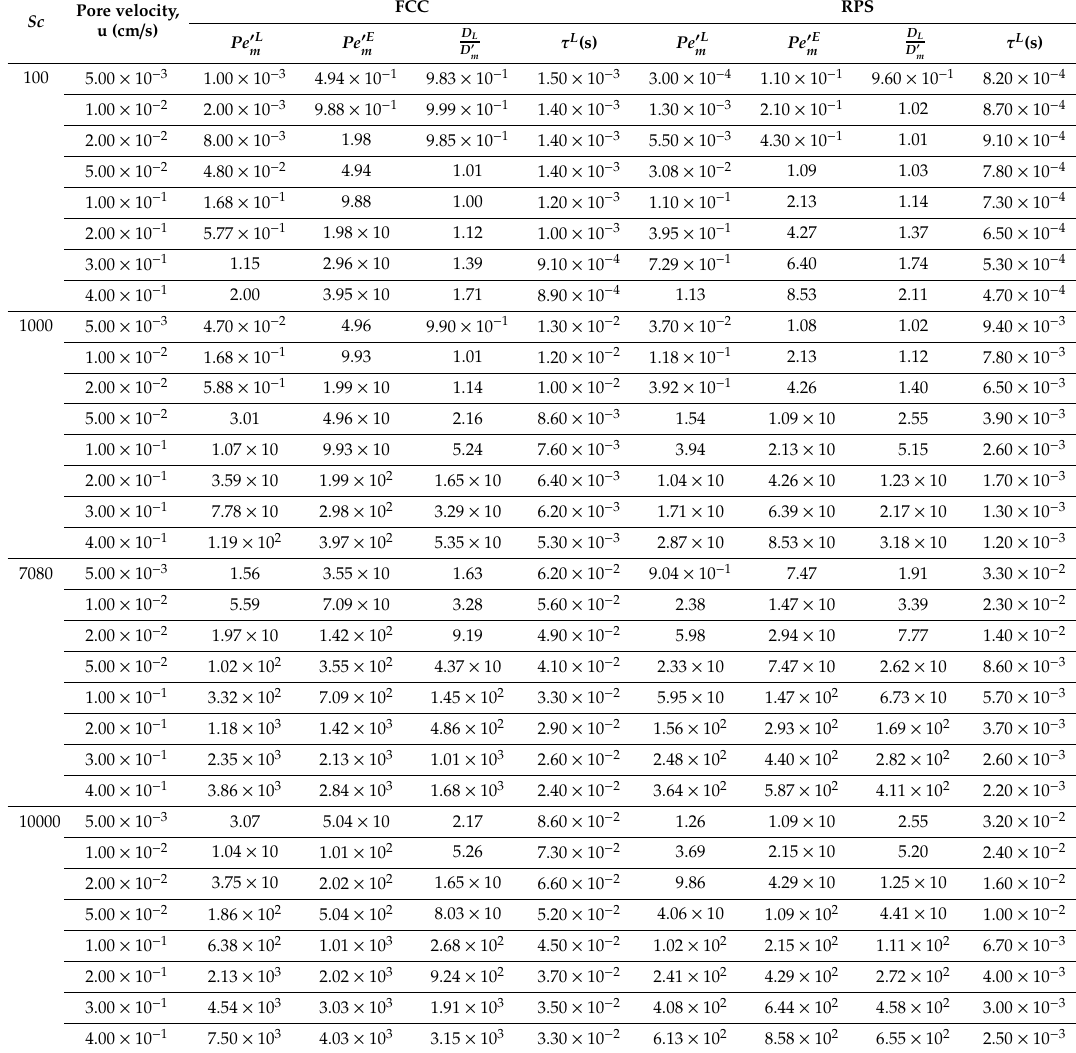
Table A2. Summary of the Results Related to the ratio of the Hydrodynamic Dispersion Coe ffi cient over the E ff ective Molecular Di ff usion Coe ffi cient together with Eulerian and Lagrangian Peclet Numbers